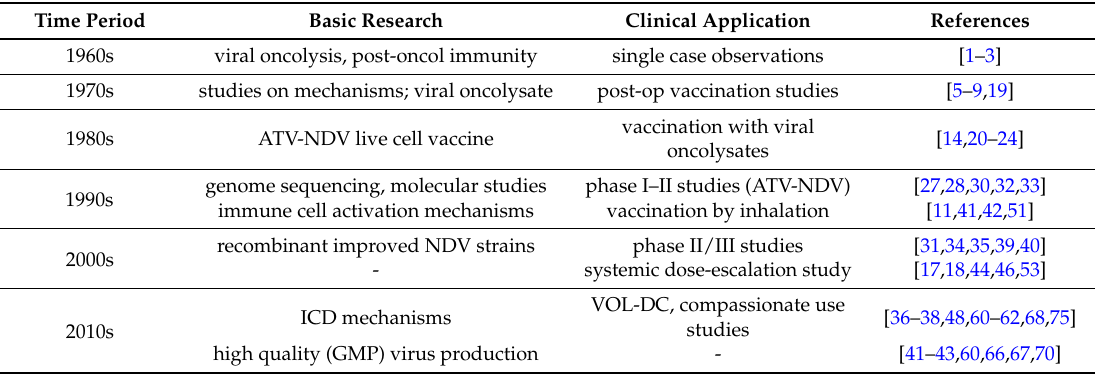
Table 1. Fifty years of research on